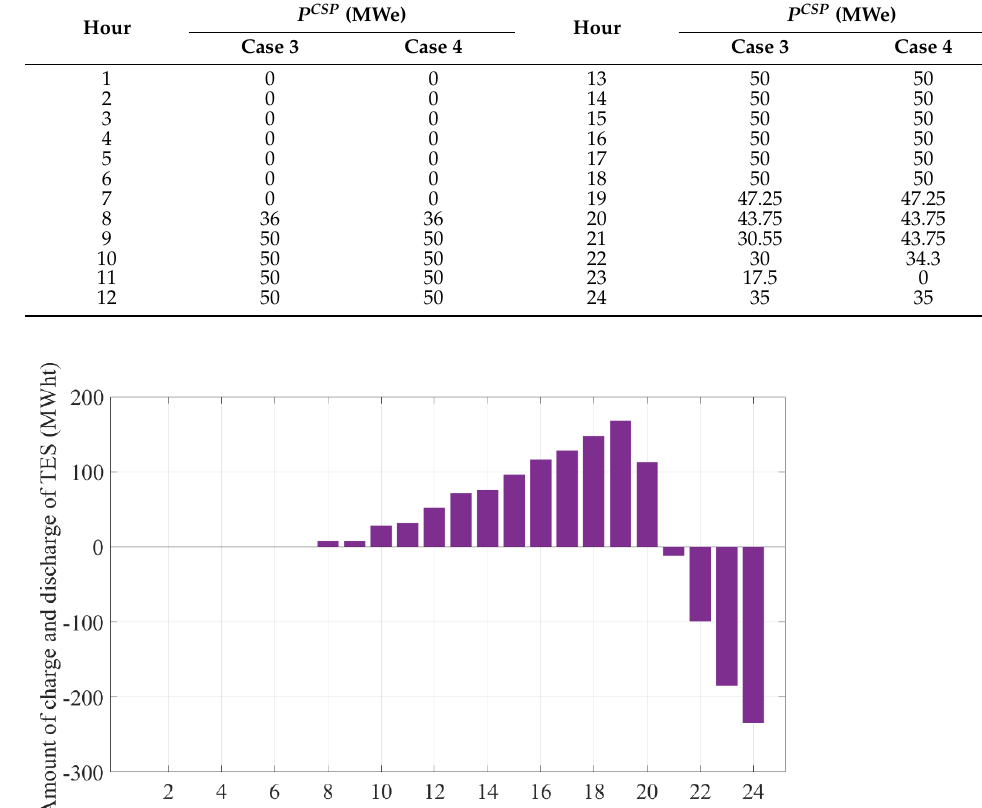
Table 5. Optimal operation scheduling for the CSP plant.